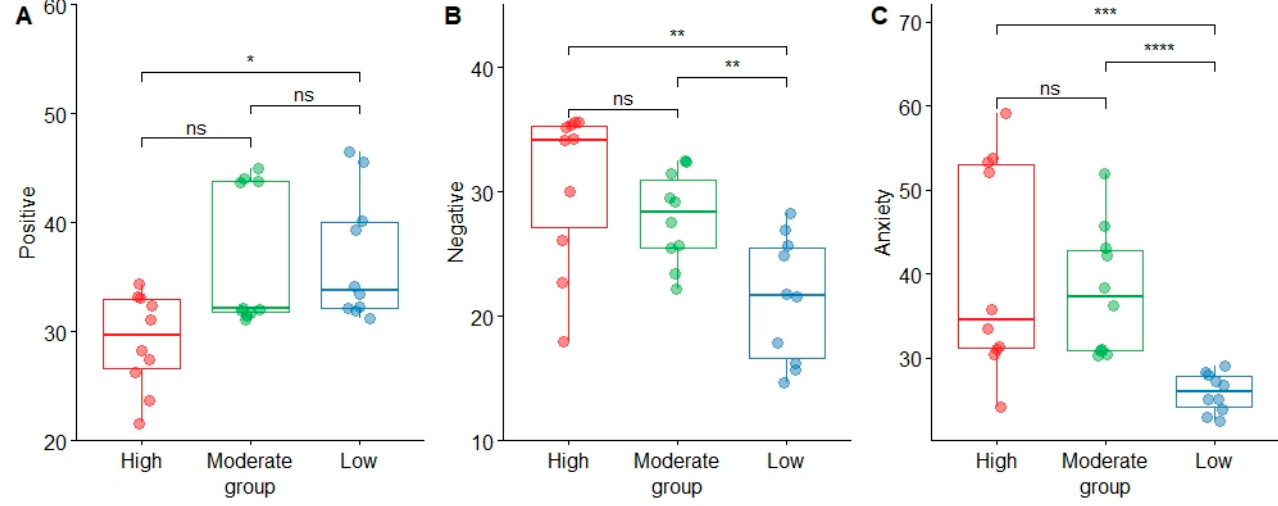
Figure 3. Differences in visitors’ positive ( A ), negative ( B ), and anxiety ( C ) emotions vary along three disturbances of urban mountain parks in Fuzhou, China. Boxplots show a range of data about the median (bold horizontal line), with the colored box depicting the 25th and 75th quartiles. Statistical significance level of analysis with Wilcoxon rank-sum tests (ns = not significant; * = p < 0.05; ** = p < 0.01; *** = p < 0.001; **** = p < 0.0001).